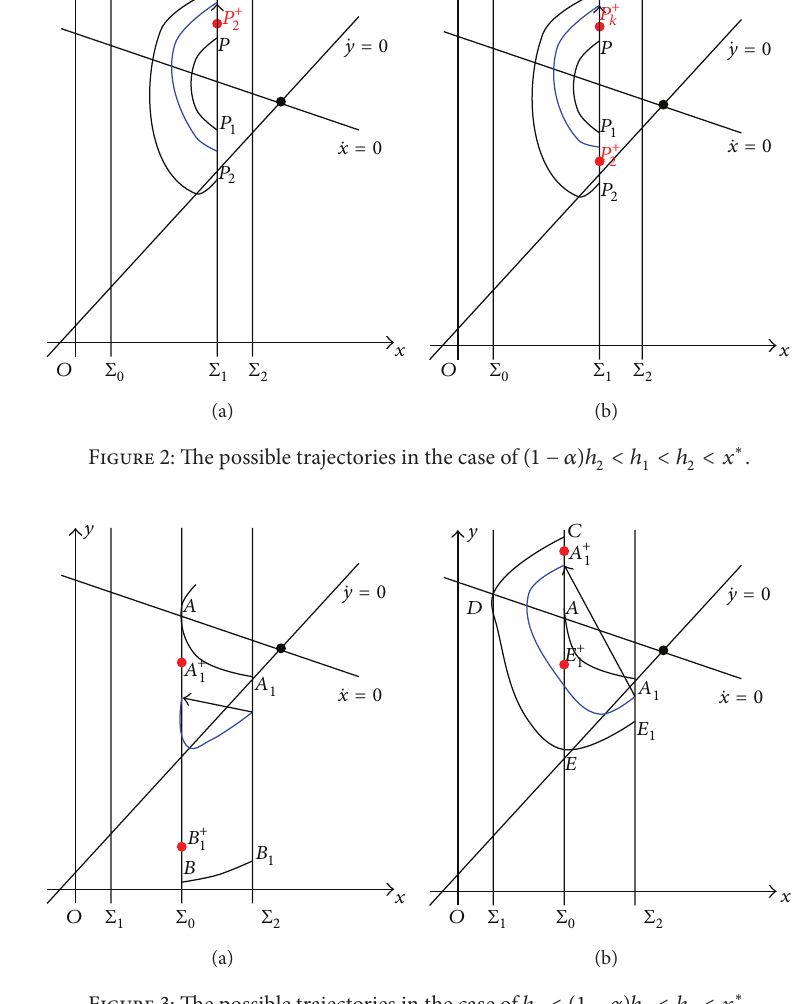
Figure 3: The possible trajectories in the case of ℎ 1 < (1 − 𝛼)ℎ 2 < ℎ 2 < 𝑥 ∗